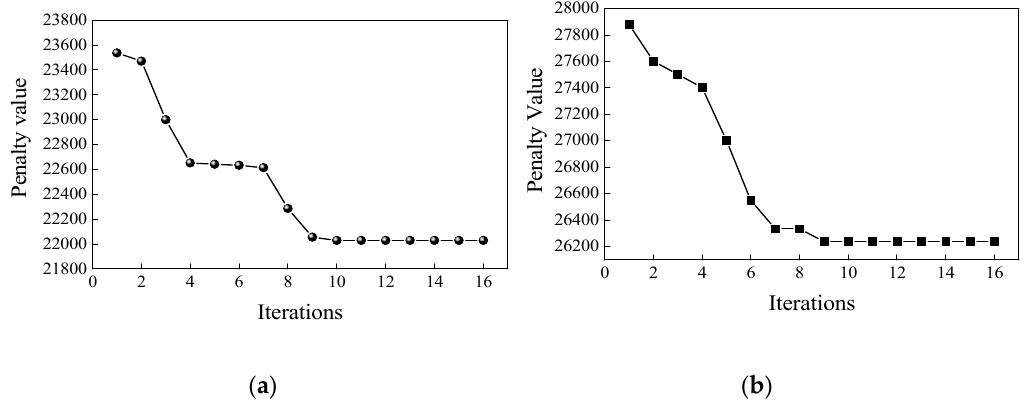
Figure 11. ( a ) TOU electricity pricing not considered ( b ) TOU electricity pricing considered Convergence curve resulted from genetic algorithm iterations.